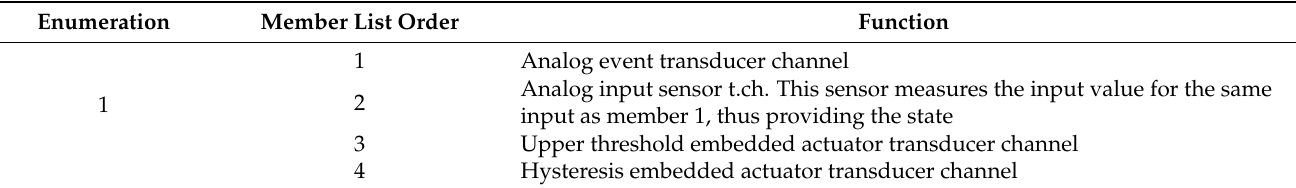
Table 2. Type 1 control group specified in the Meta